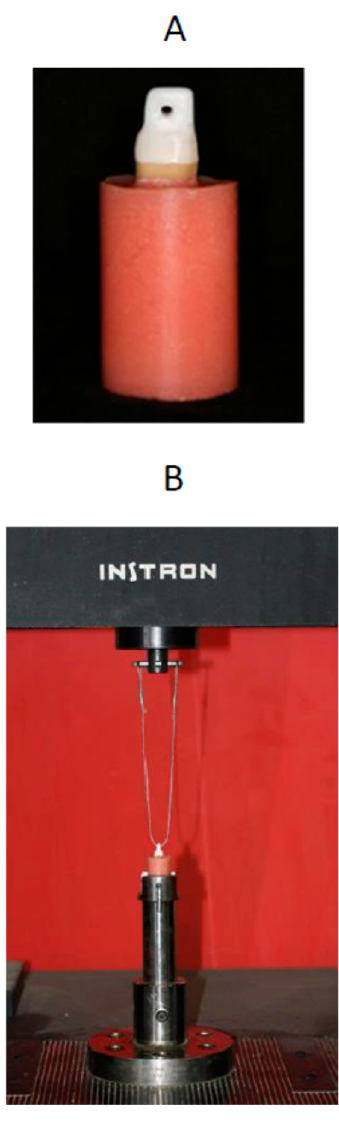
Figure 5. ( A ) Zirconium oxide coping showing the design of the occlusal surface to enable removal after cementation; ( B ) Metal cable connecting the coping with the universal testing machine.